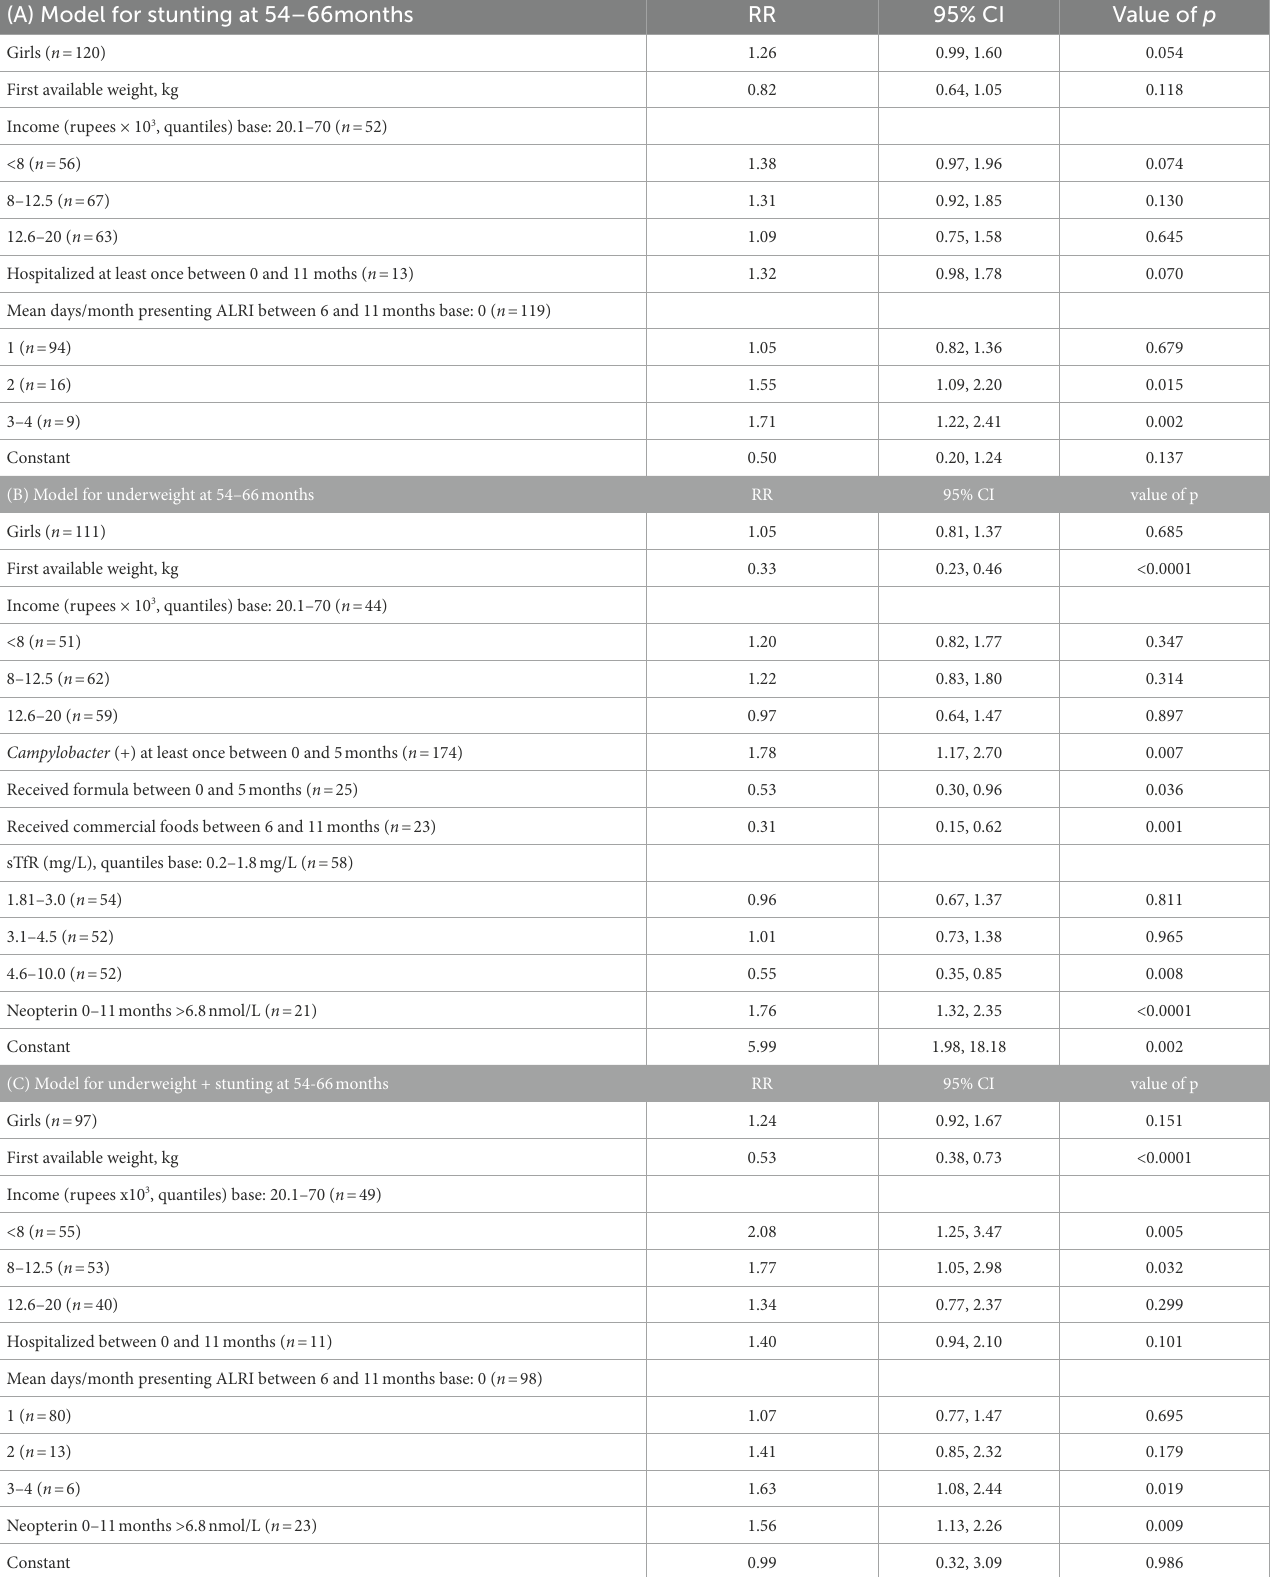
TABLE 3 Multivariate logistic regression models for (A) stunting, (B) underweight, and (C) combined stunting + underweight compared with non-stunted/ non-underweight children at 54–66 months. (A) Model for stunting at 54–66